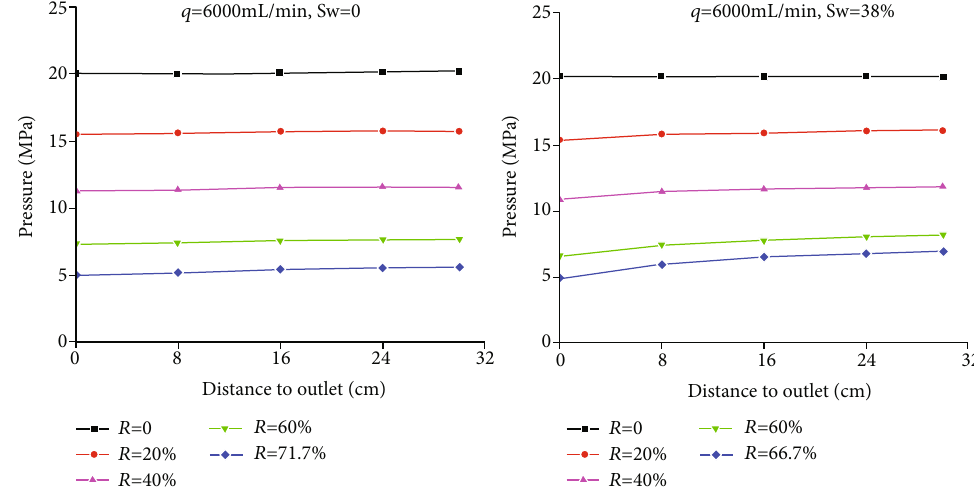
Figure 3: Comparisons of reserve utilization in the Su1 core under the dry and irreducible water conditions.